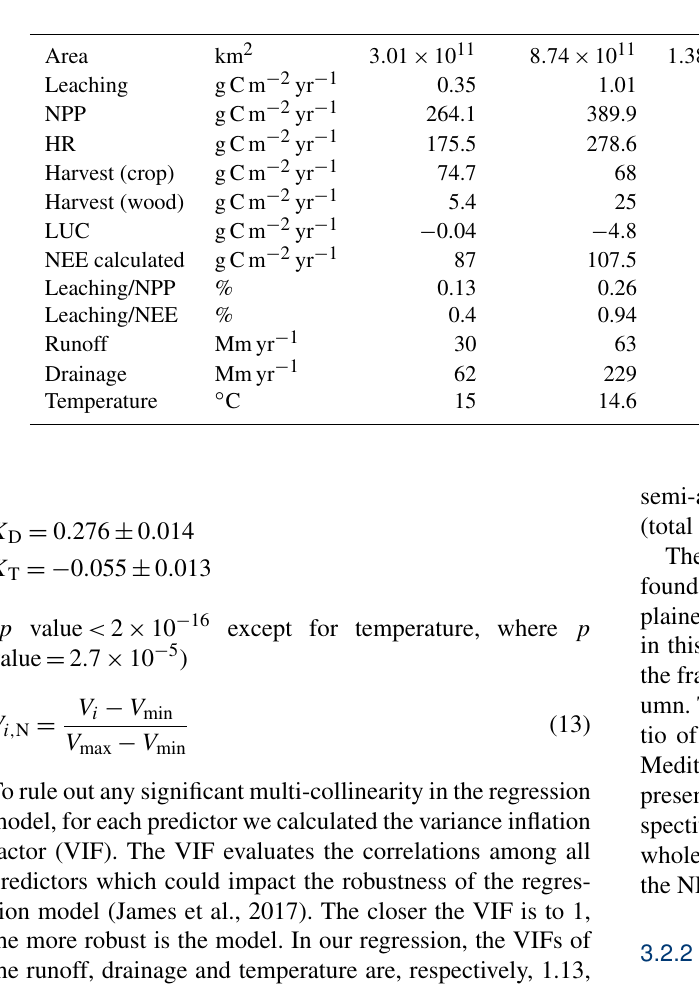
Table 3. Key physical and biogeochemical characteristics of the six dominant climate zones of the European domain.